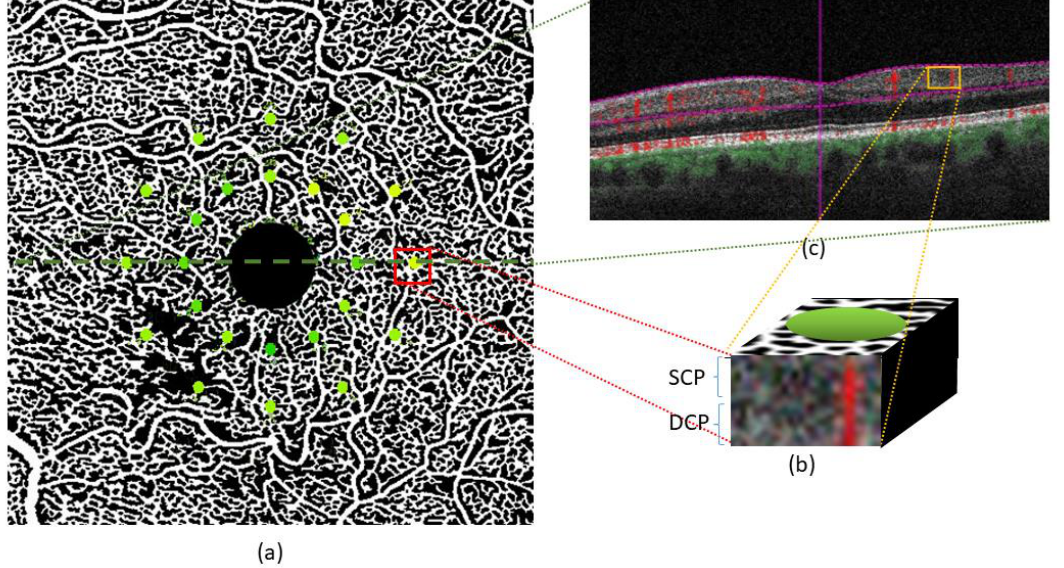
Figure 2. ( a ) Grid overlaid onto binarized SCP, the green circles represent the entity of FLS in the focal retinal area; ( b ) focal cube of the inner retina in which the SS-OCTA detect the blood flow (flow signal, FS) in the retina. The focal SCP and DCP FS was calculated in areas of 150 micron radius around each grid point. ( c ) Position of the cube in the B-scan of the macula.